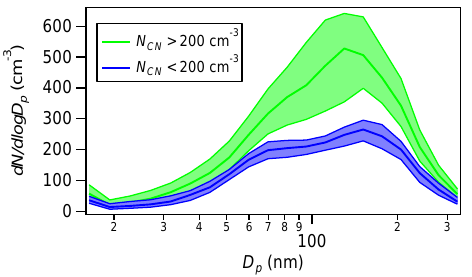
Figure 5. Median and interquartile ranges of particle number size distributions observed during high ( > 200cm − 3 ) and low ( < 200cm − 3 ) total particle number concentrations.